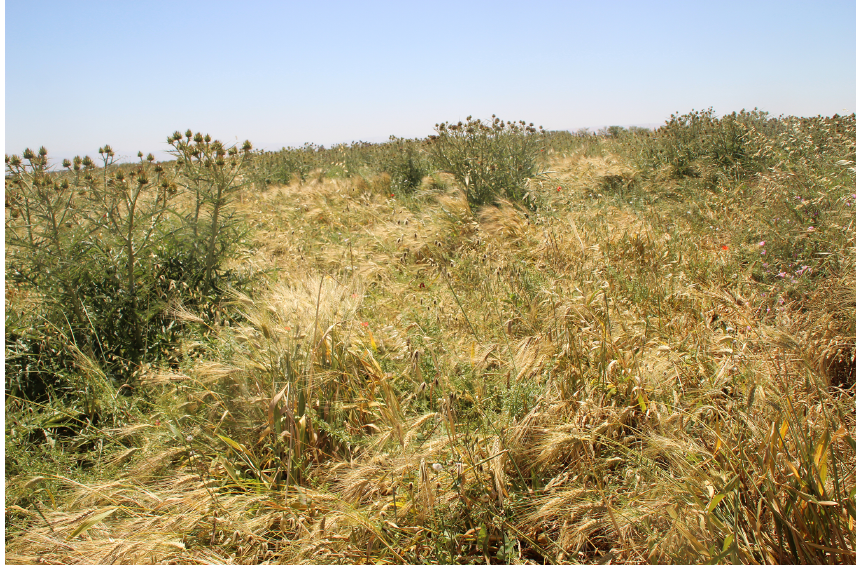
Figure A1. Picture taken over F2 during 2017/18 growing season (14 May 2018) illustrating the specific growing conditions (adventices and stems laid down by wind).